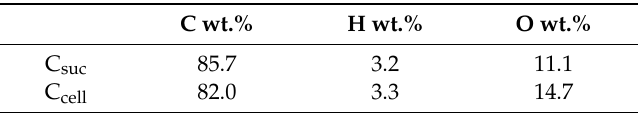
Figure 2. Thermogravimetric curves of the WO 3 / C suc and WO 3 / C cell composites under air between 25 to 800 °C. Table 1. Chemical composition of the saccharide-derived carbon phases. The oxygen amount was calculated with respect to 100% of the